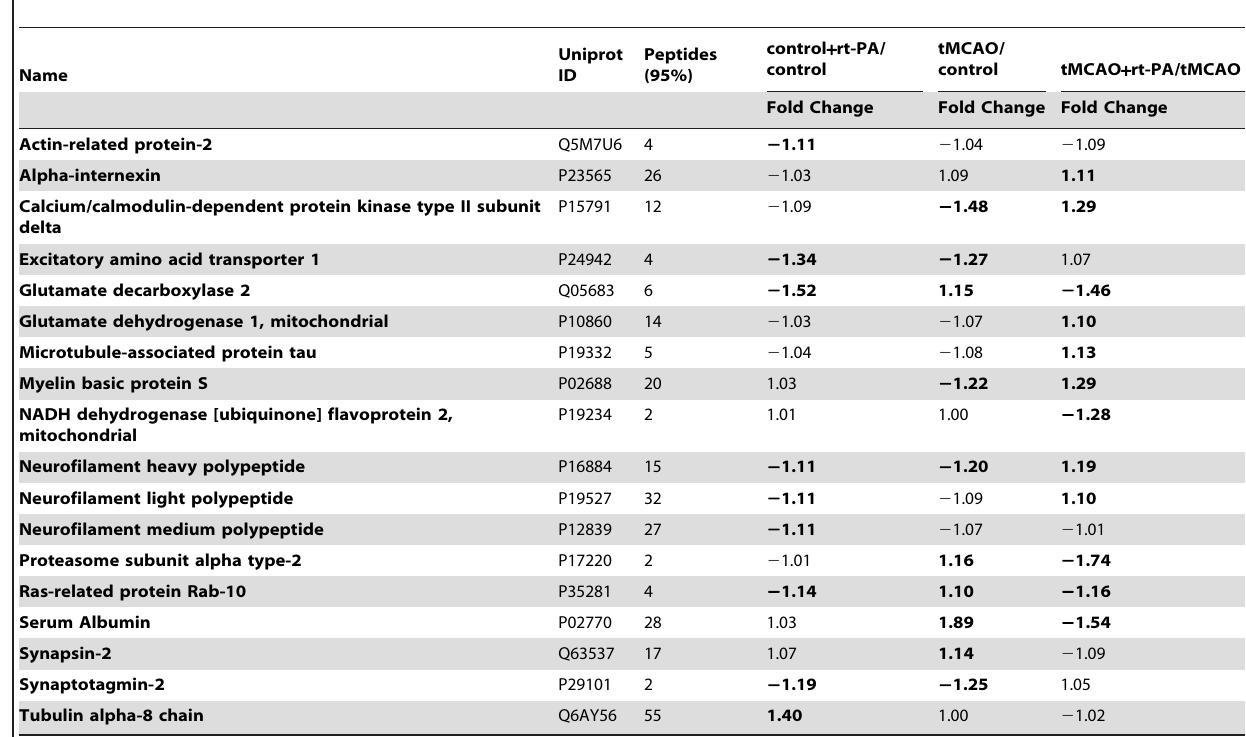
Table 1. Between group comparisons of protein expression fold changes after tMCAo and rt-PA administration meeting the criteria outlined in ‘Statistical